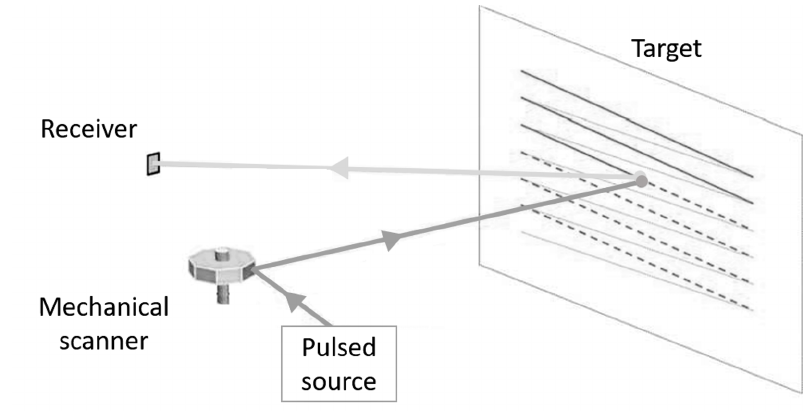
Figure 6. Schematics of a typical light detection and ranging (lidar) imaging system based on mechanical